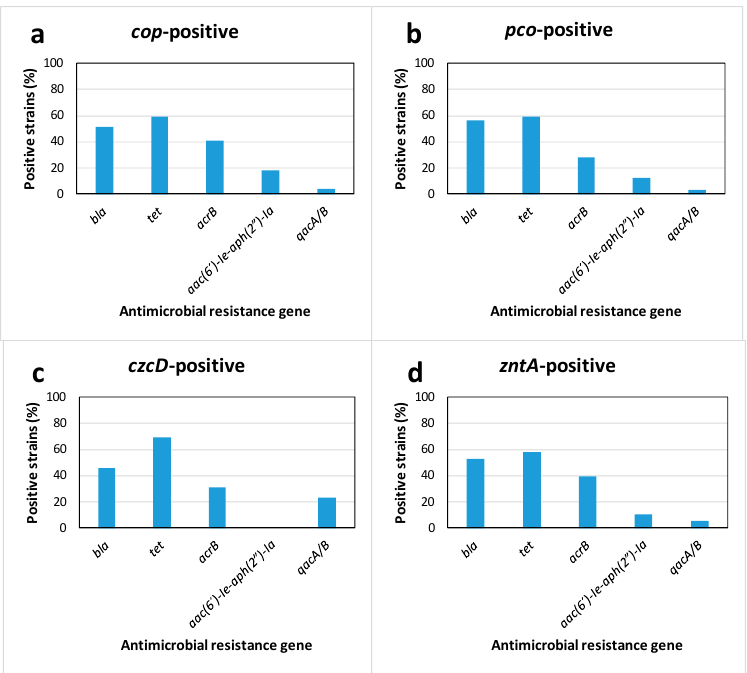
Figure 1. Association between heavy metal tolerance and antibiotic resistance genetic determinants. The percentage of genetic determinants of antimicrobial resistance found in strains that tested positive for heavy metal tolerance genes cop ( a ), pco ( b ), czcD ( c ) or zntA ( d ) are shown.